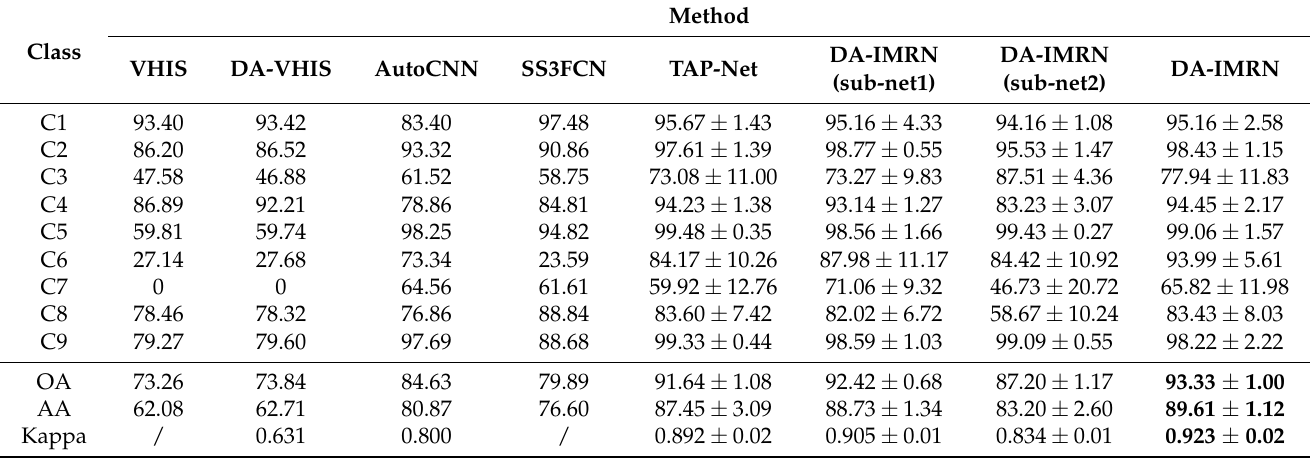
Table 4. Pavia University dataset: Classification results in terms of the per-class accuracy, OA, AA (in %), and the Kappa scores. In the last four columns, the results are displayed in the form of mean ± standard deviation.